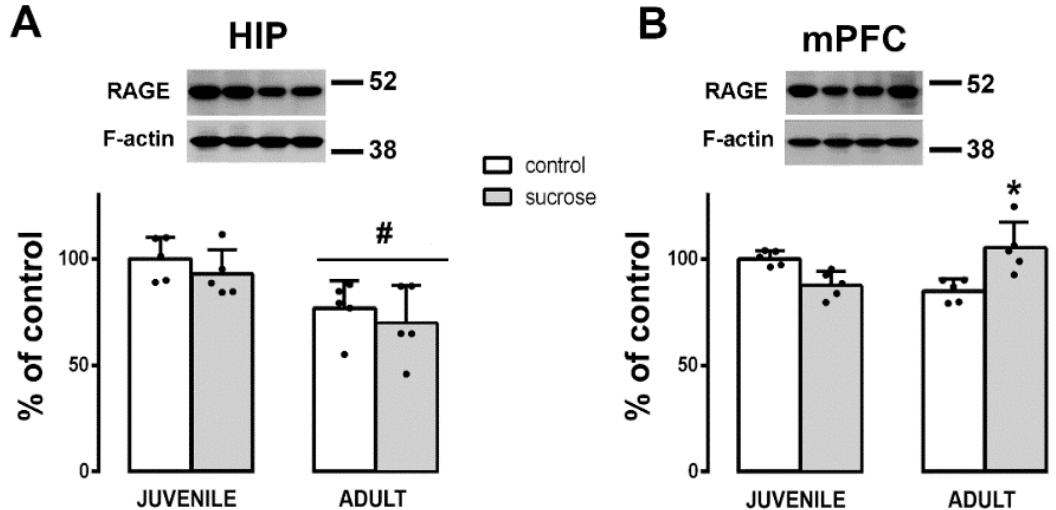
Figure 6. ( A ) Western blot of RAGE in the ( A ) HIP and the ( B ) mPFC of control (white bars) and sucrose-exposed (gray bars) animals from juvenile or adult groups. Data were quantified by densitometric analysis and corrected with reference to the F-actin loading control. Representative pictures of RAGE expression and the F-actin loading control are shown in the upper panel. Data are presented as mean ± SD from two independent experiments, n = 5. Tukey’s post hoc test showed differences by treatment, * p < 0.05 and by age # p < 0.005.